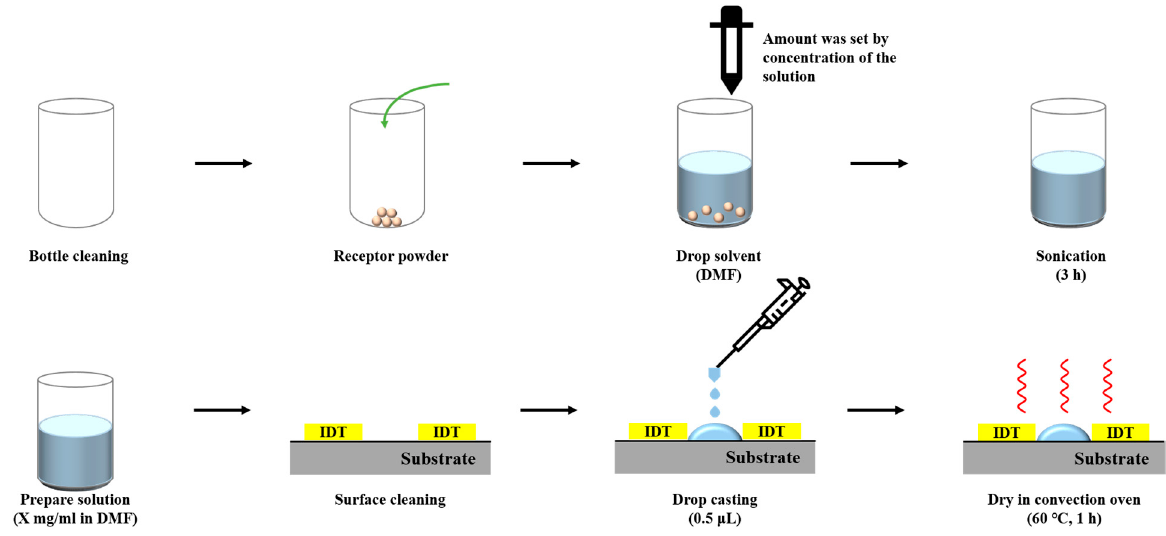
Figure 5. The solution manufacturing process and drop casting process.